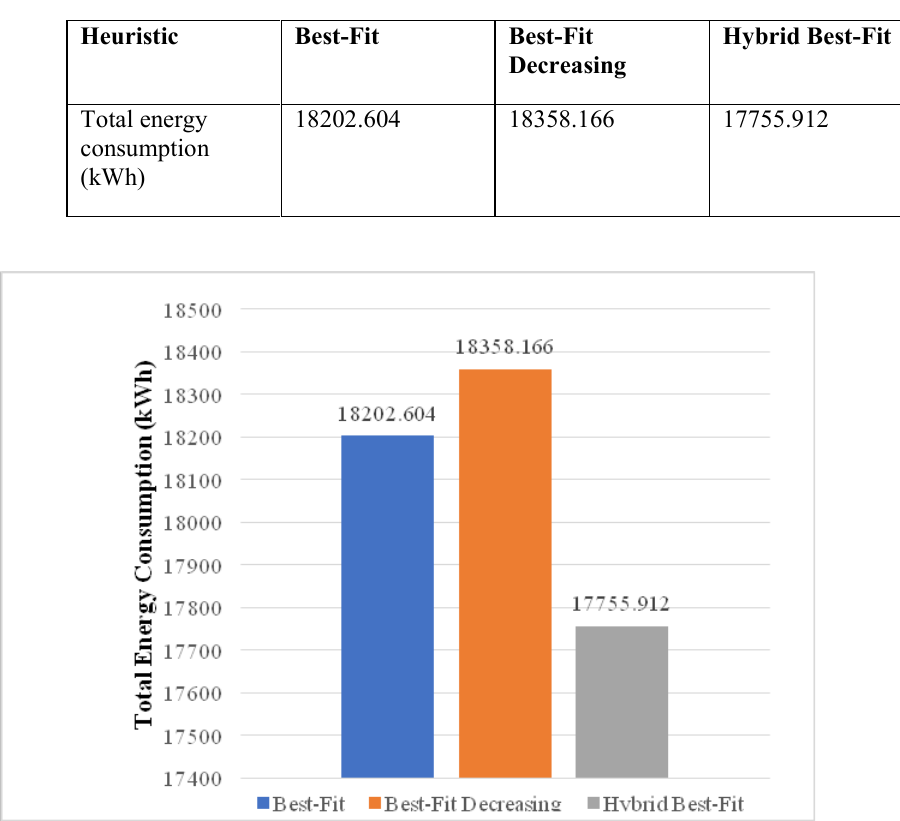
Figure 4. Proposed HBF heuristic saves energy compare to the existing heuristics BF and